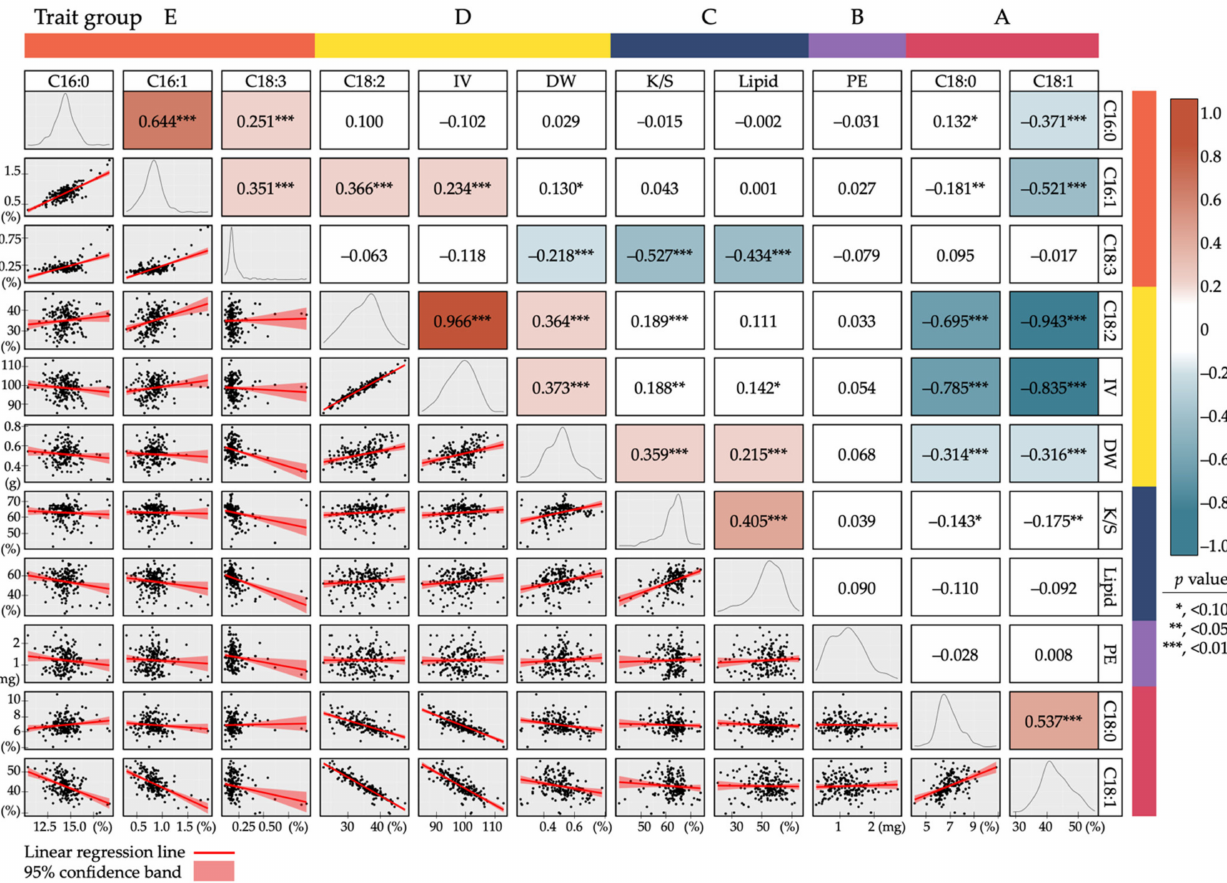
Figure 6. Matrix of scatter plots and Spearman’s rank correlations for seed chemical components among the Botswanan Jatropha accessions. The chemical trait groups ( A – E ) conform with Figure 5. Scatter plots are presented in the bottom left half, where each accession is plotted as a black point. The red straight lines and surrounding pale red bands show the linear regression lines and their 95% confidence bands, respectively. The Spearman’s rank correlation coefficients are presented in the upper right half. The colors of the boxes represent positive or negative correlations according to a color scale on the top right vertical axis. The significance of the differences was calculated using the Wilcoxon test, and p values below 0.10, 0.05, and 0.01 are expressed as *, **, and ***,